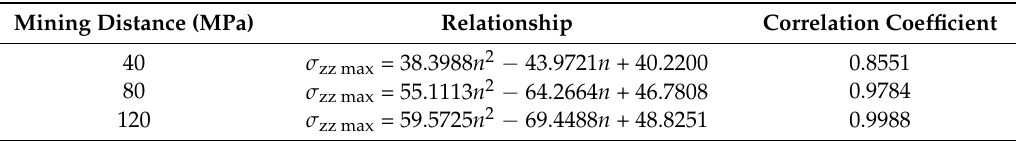
Table 10. Relationship between the maximum stress of the rock mass in the coalface and the Talbot index of the cemented rockfill at different mining